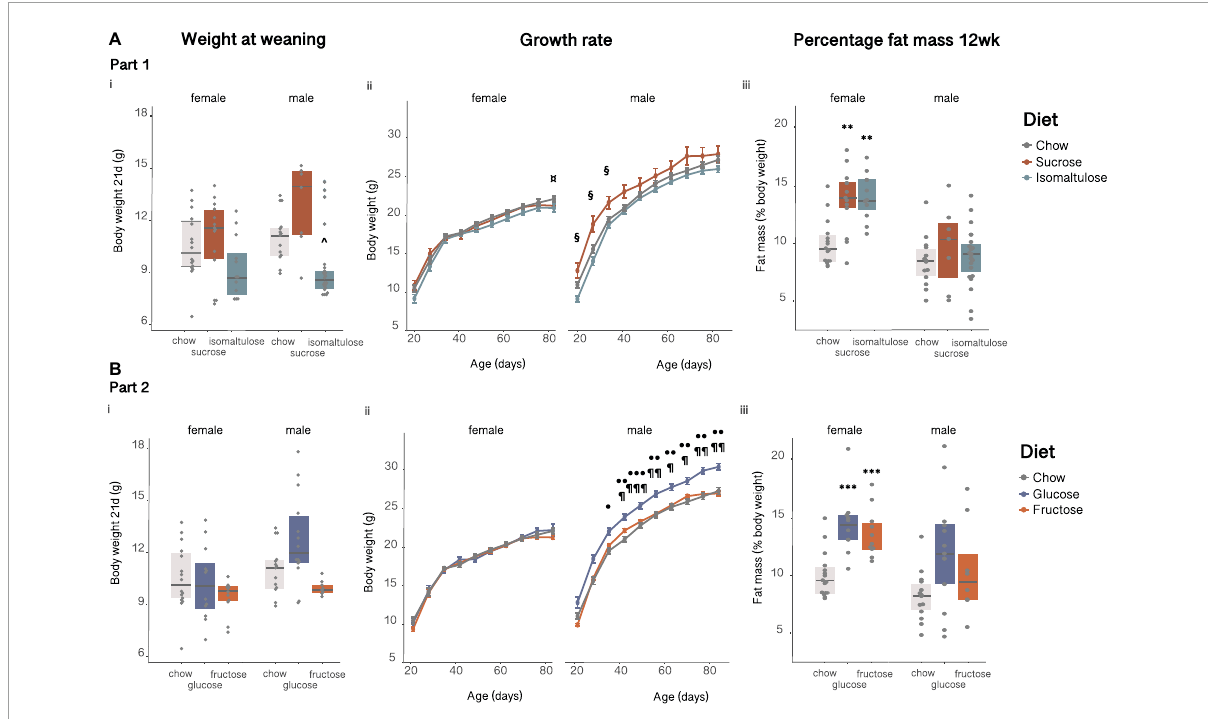
FIGURE5 Female and male pup (A) in Part 1 and (B) in Part 2: (i) body weight at weaning, (ii) body weight over time from 3 to 12 weeks of age and, (iii) percentage body fat at 12 weeks. n = 7–23 per diet per sex. Line graphs depict data as mean ± SEM. ** p < 0.01 vs. chow; *** p < 0.001 vs. chow; ˆ p < 0.05 vs. sucrose; p < 0.05 isomaltulose vs. chow; p < 0.05 sucrose vs. isomaltulose; · p < 0.05 glucose vs. chow; ·· p < 0.01 glucose vs. chow; ··· p < 0.001 glucose vs. chow; p < 0.05 glucose vs. fructose; p < 0.01 glucose vs. fructose; p < 0.001 glucose vs.